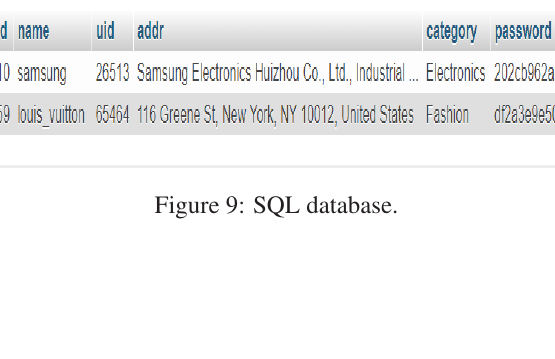
Figure 11: Completing the transaction with metamask wallet